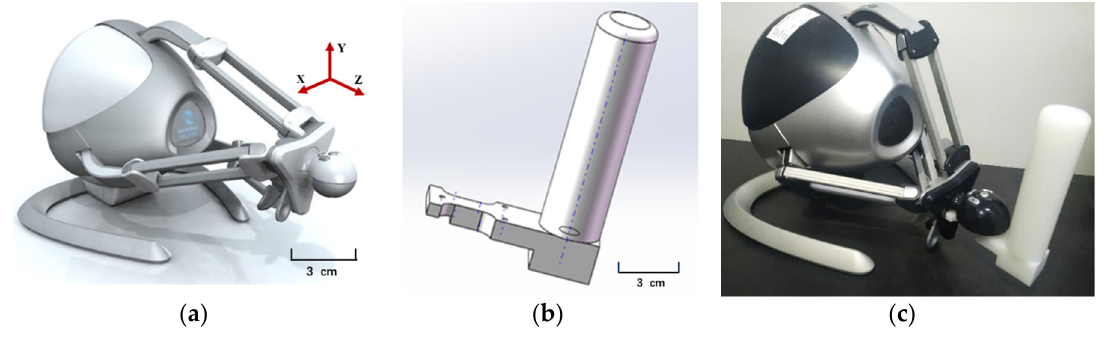
Figure 2. ( a ) Haptic force feedback robot Novint Falcon. ( b ) 3D parts design drawing of the modified handle. ( c ) Effect diagram of the modified handle installed on the Novint Falcon.